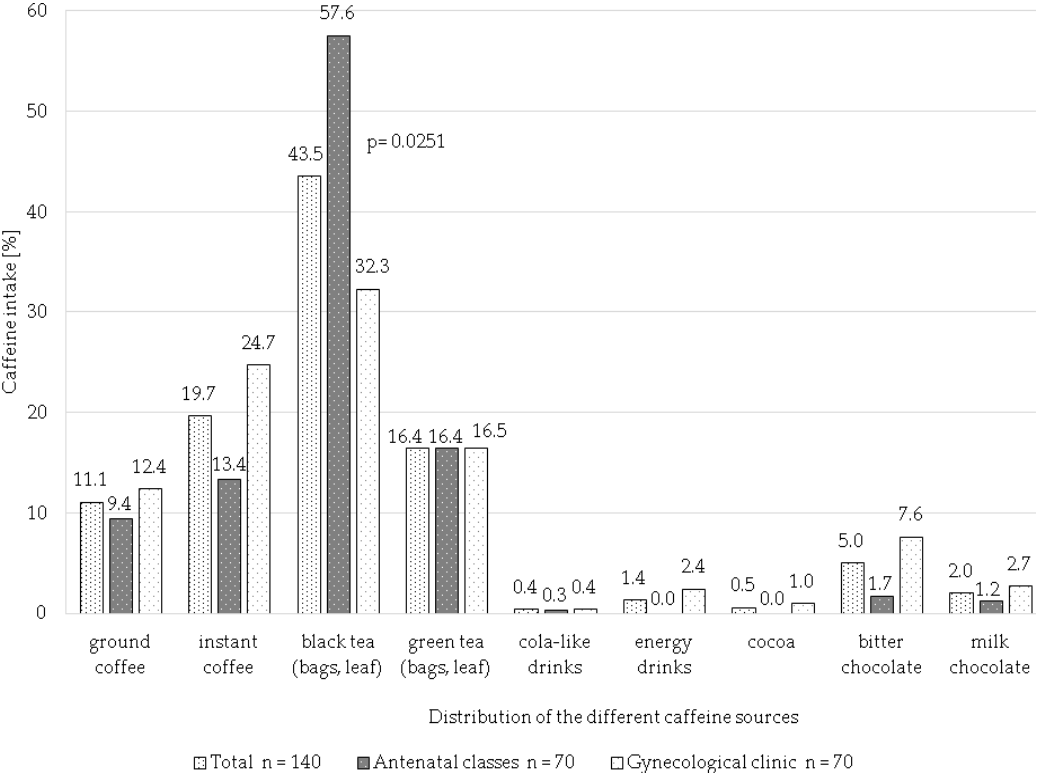
Figure 1. Daily caffeine intake versus source of caffeine, in total and by group (%).